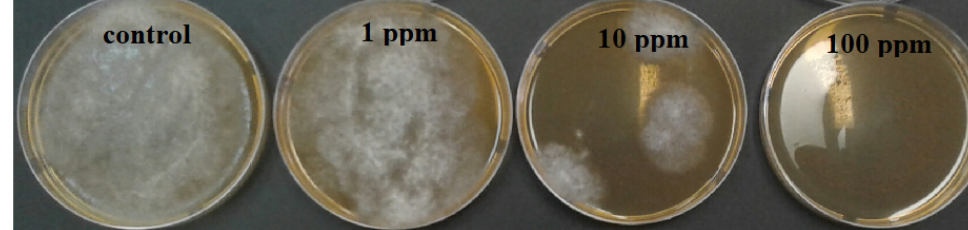
Figure 5. Germination inhibition of B. cinerea spores by Ag NPs of 0 (as control) 1, 10, and 100 ppm concentrations dispersed in agar medium.